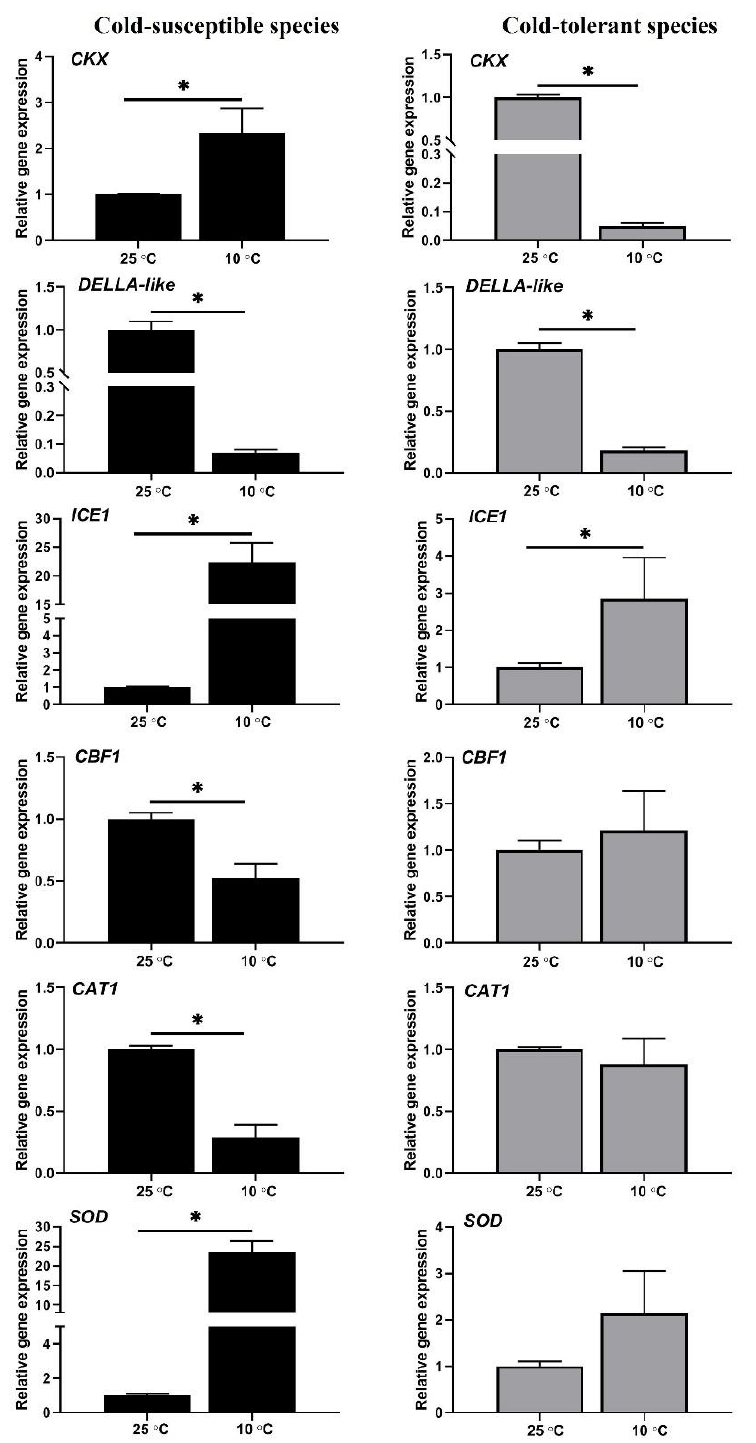
Figure 2. Expression patterns of the cytokinin oxidase/dehydrogenase (CKX), DELLA-like (as a GA signaling suppressor), INDUCER OF CBF EXPRESSION 1 (ICE1), C-REPEAT BINDING FACTOR 1 (CBF1), CAT1 (as a catalase biosynthesis gene), and superoxide dismutase (SOD) genes under low temperature (10 °C for three days). An asterisk above a bar shows a significant difference ( p -value < 0.05) between the low-temperature and normal-temperature treatments ( n = 4) (according to Student’s t -test).